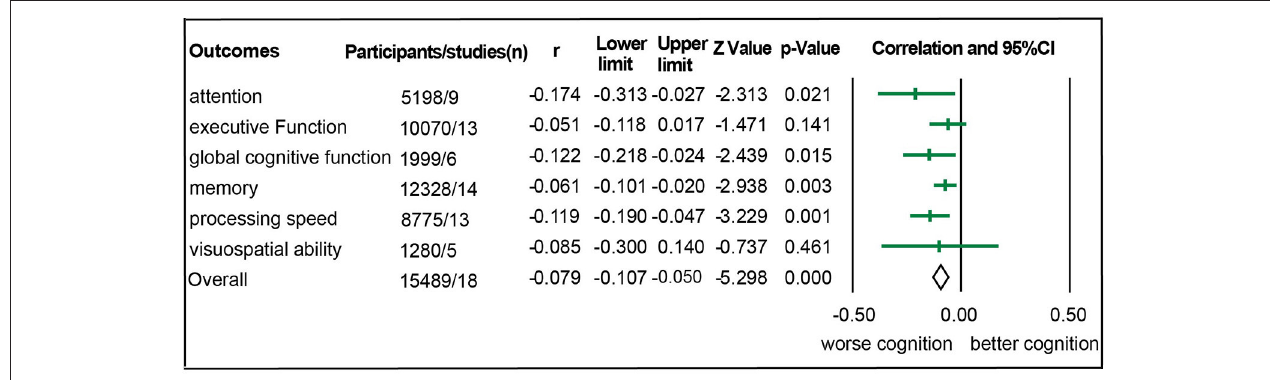
FIGURE 2 | Forest plot for association between aortic stiffness and domains of cognitive